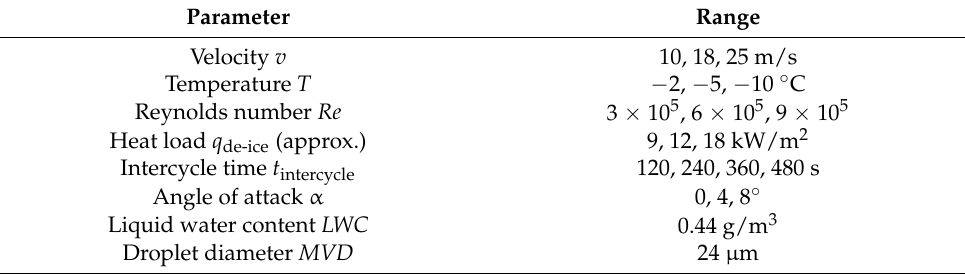
Table 2. De-icing test